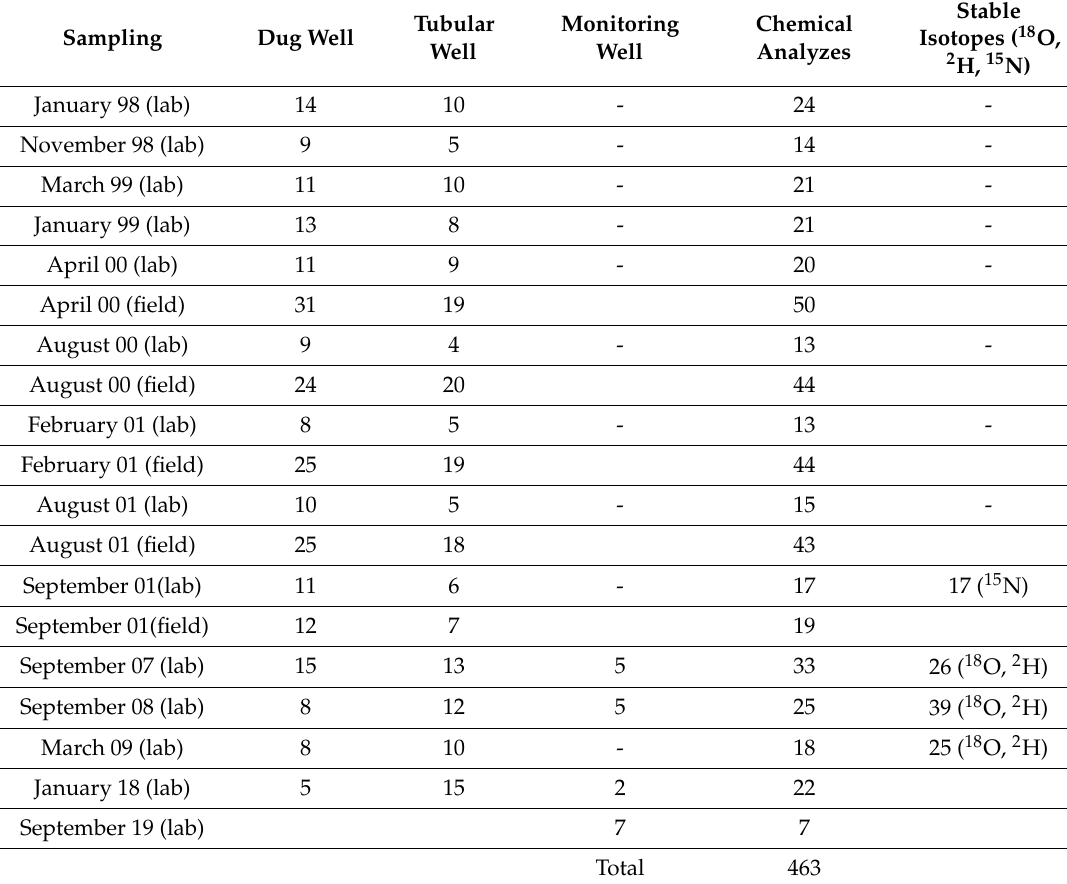
Table 1. Groundwater samples for chemical and isotopic